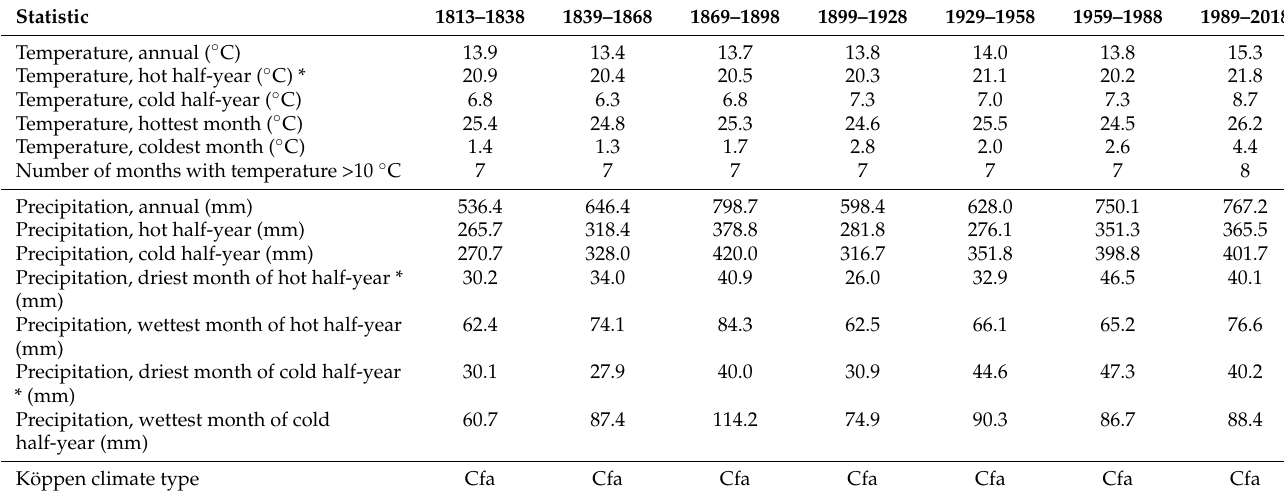
Figure 7. Evolution of the empirical probability dry of daily precipitation (relative frequency of days without precipitation) in Bologna, as a climatic element, seen at the annual and the climatic time scales of 10 and 30 years. Because in Bologna there is no dry season, the effect of seasonality on precipitation is low and can be neglected in the stochastic characterisation of the precipitation process. The negligible effect is manifest in the climacogram of Figure 5, where a monotonic decrease is observed for the entire range of scales. However, in other climatic zones the seasonality is prominent. Even in Bologna, in the temperature process, which has been used for the climatic classification in Table 2, the effect of seasonality is substantial. The climacogram can no longer be fully described by Equation (7). Table 2. Climatic time series of temperature and precipitation in Bologna that are used for the Köppen climate classification.